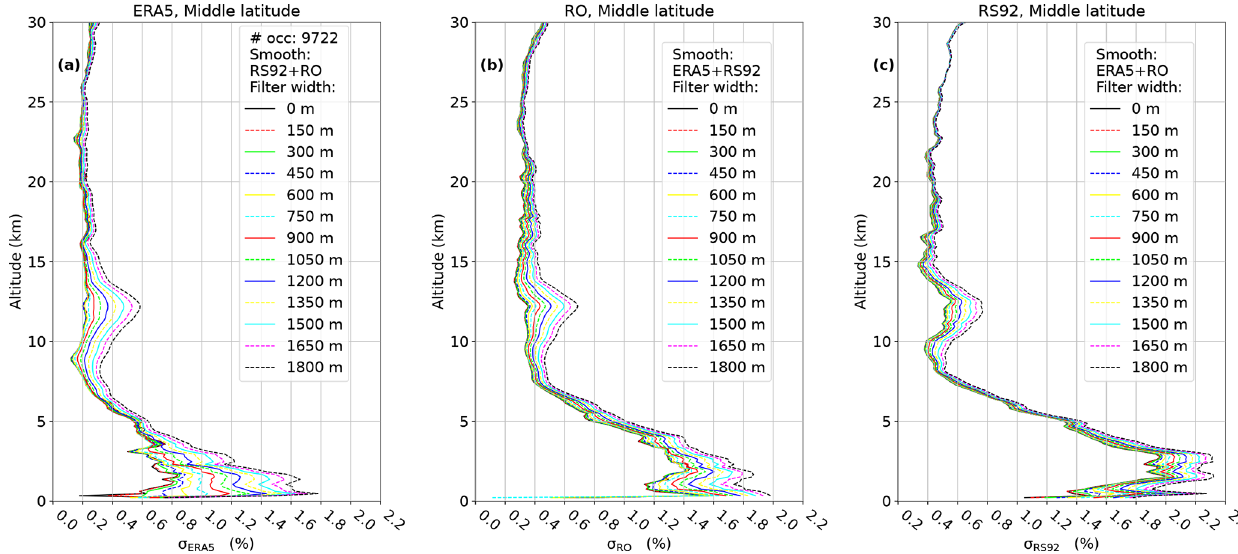
Figure 7. Effect of smoothing on error standard deviations of ERA5 (a) , RO (b) , and RS92 (c) estimated by 3CH. Note that the x axis is shifted by 0.2% in panel (c) . All plots are for middle latitudes. The standard deviations are divided by the mean ERA5 refractivity. The filtering width is defined as 2 times the standard deviation of the Gaussian filter function. The single curves are most easily identified at a given altitude by counting the curves from one side. For each data set, the smoothing is only applied on the two other data sets.